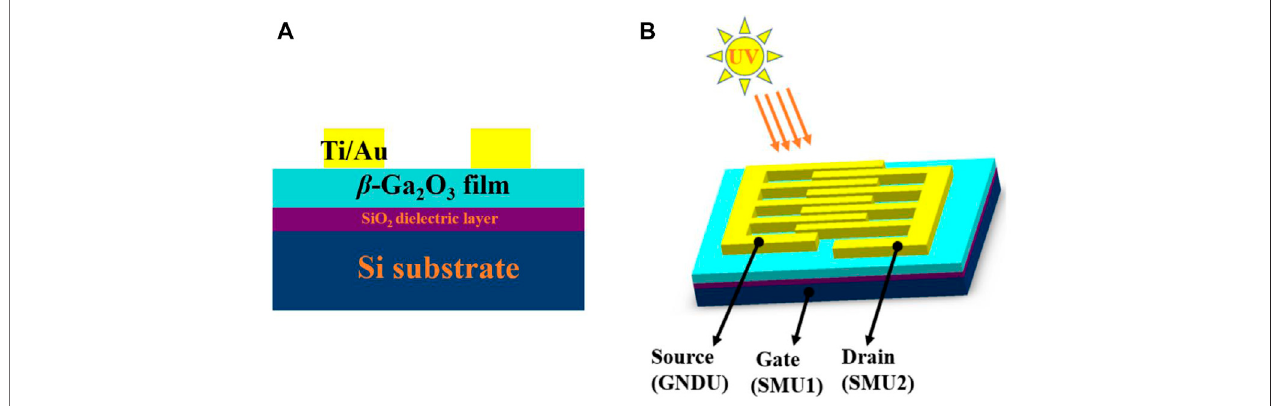
FIGURE 1 | (Color online) (A) Schematic cross section. (B) Schematic diagram of the fabricated β -Ga 2 O 3 fi lm device with the back-gate MOS